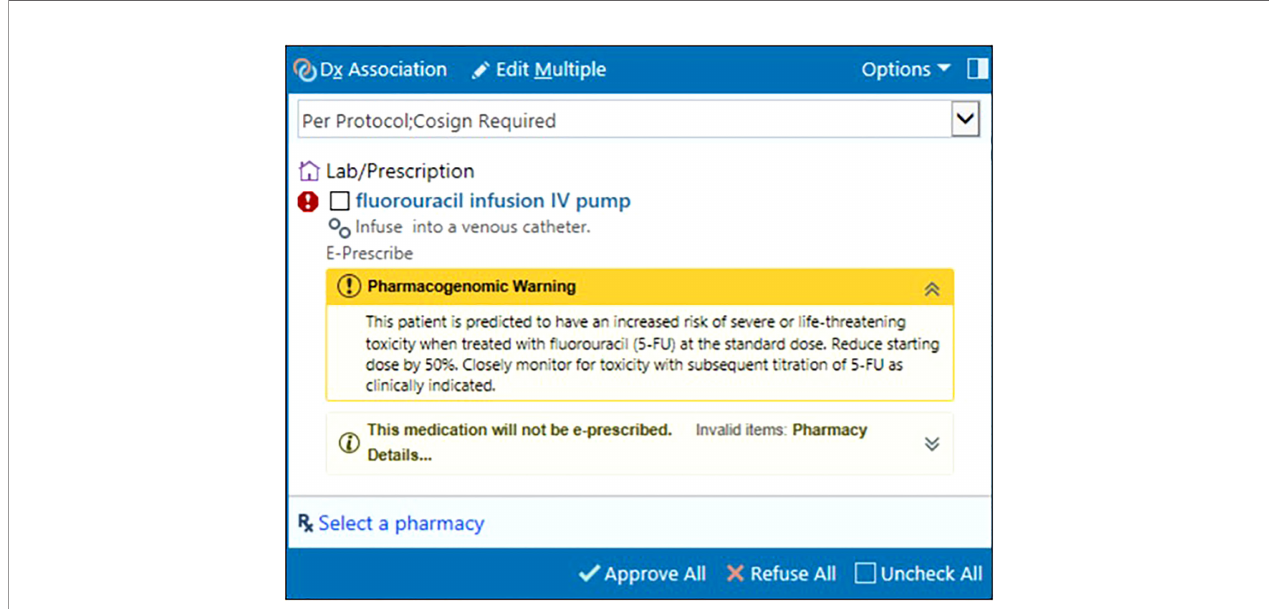
FIGURE 3 | In-line warning at fl uorouracil order entry informing provider of actionable DPYD results, clinical implication, and dose recommendation. © 2021 Epic Systems